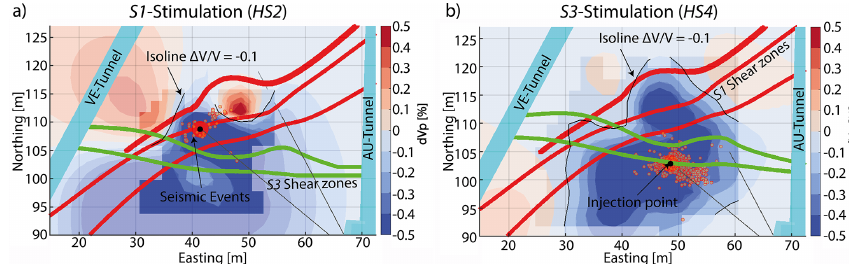
Figure 15. Comparison between active and passive seismic observations during S1 (a) and S3 (b) stimulations in map view. The extent of the active seismic velocity change was traced with the − 0 . 1% isoline. This figure was modified after Schopper et al. (2020) and Villiger et al.